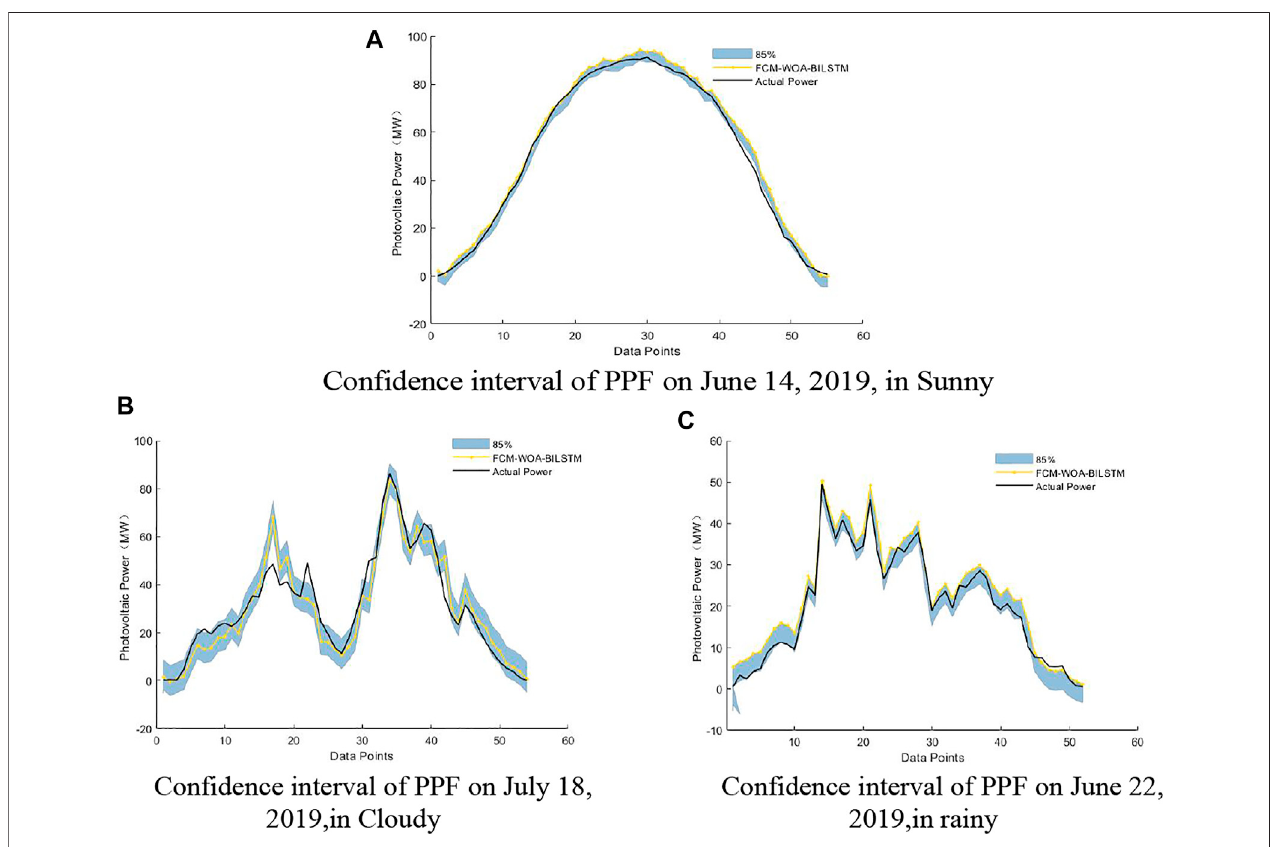
FIGURE 15 | 85% Con fi dence interval of PPF under different climatic conditions.